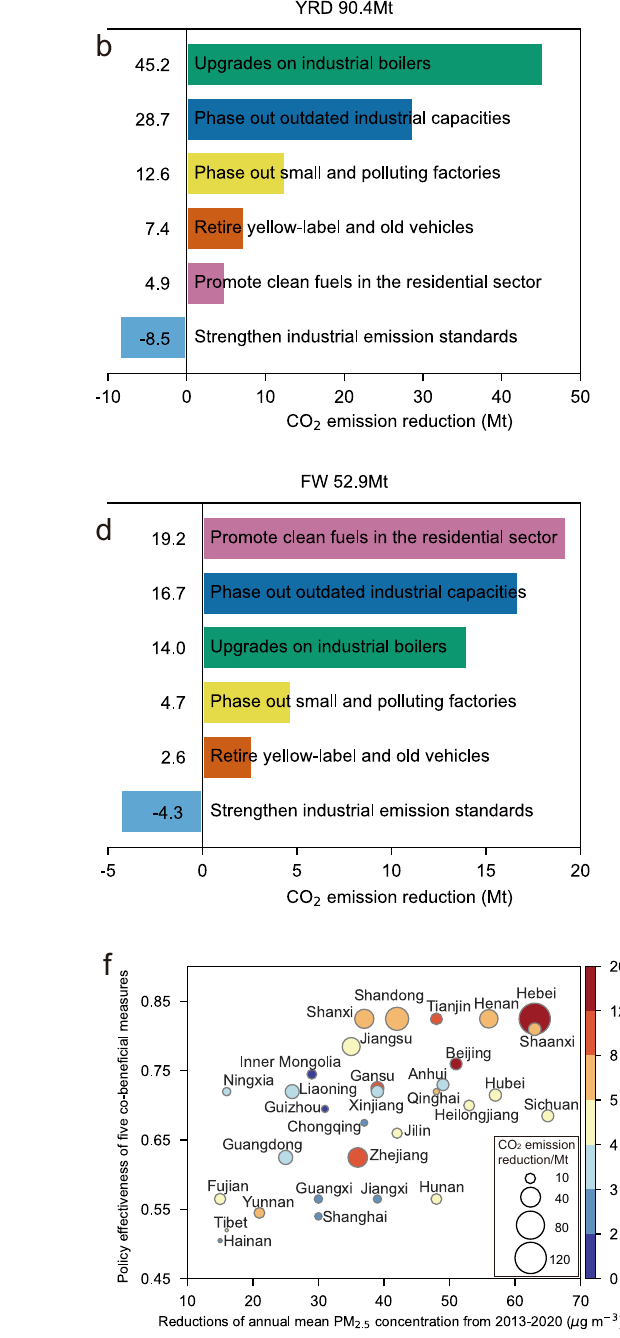
Fig. 3 | Regional patterns of CO 2 emission reduction co-bene fi ts in 2020. a – d CO 2 emission reduction from six measures in Beijing – Tianjin – Hebei region (BTH),YangtzeRiverDeltaregion(YRD),PearlRiverDeltaregion(PRD),andFenwei Plain region (FW), respectively. e The provincial CO 2 emission reduction in 2020. f The relationship between the policy effectiveness, air quality improvement, and CO 2 emission reduction. Each bubble in f indicates a province, with the size